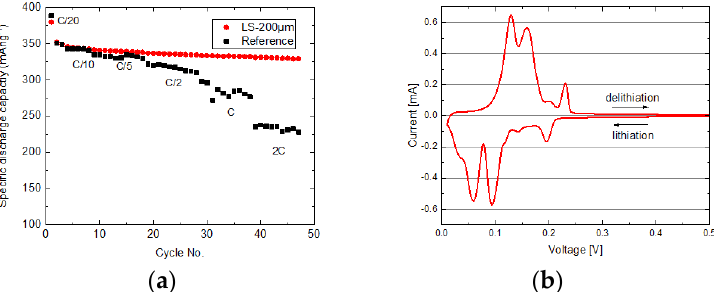
Figure 2. ( a ) Specific discharge capacity of cells with structured (LS-200 µ m) and unstructured (reference) electrodes as a function of cycle number; ( b ) cyclic voltammetry curve of the cell with an unstructured graphite